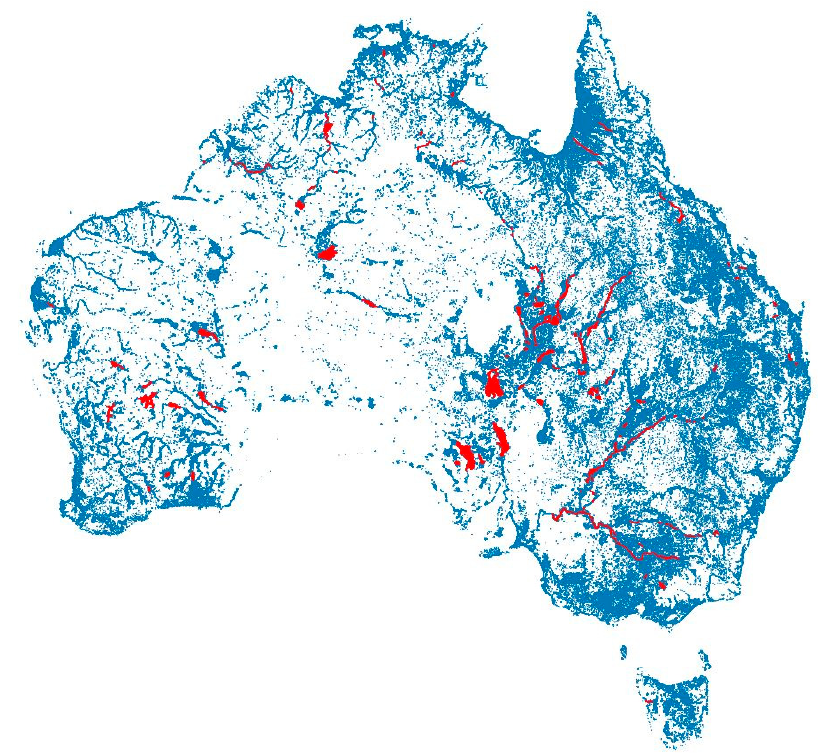
Figure A6. Initial DEA Waterbodies product, with polygons with a Polsby-Popper test value ≤ 0.005 highlighted in red.